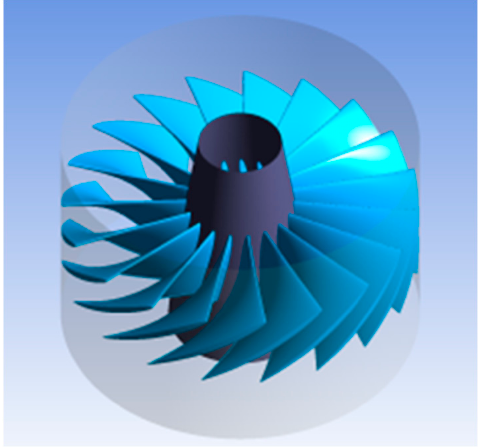
Figure 2. Initial rotor.